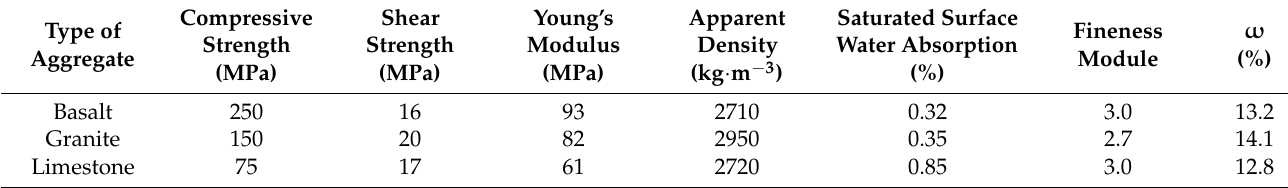
Table 3. Main physical and mechanical parameters of rock.